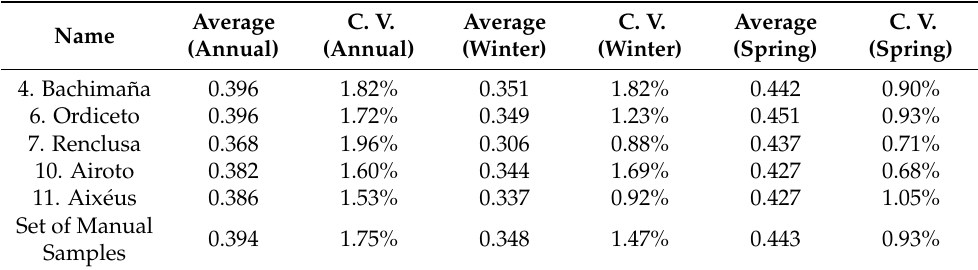
Table 3. SDEN statistics for the most representative manual samples in the same location as TNM sites and for the set of samples.